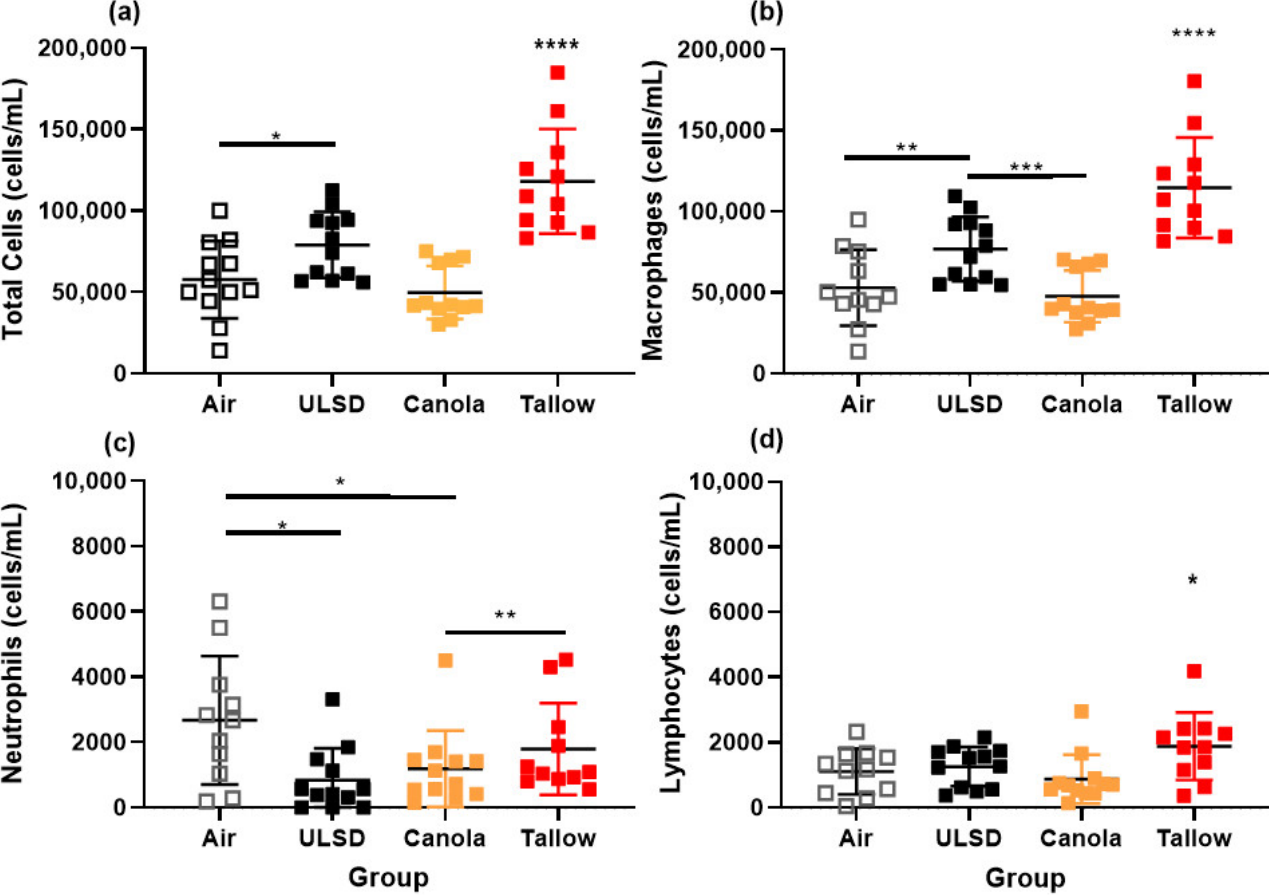
Figure 6. Cellular inflammation in bronchoalveolar lavage. Results are shown for ( a ) total cells, ( b ) macrophages, ( c ) neutrophils, and ( d ) lymphocytes ( n = 12, except Tallow where n = 11) (* = p < 0.05, ** = p < 0.01, *** = p < 0.001, **** = p < 0.0001, significant * values not located next to a line indicate that the group is significantly different to all other exposures). Note different scales. Data were analyzed using general linear modeling methodologies. Table 3. Mean (standard deviation) mediator levels in bronchoalveolar lavage fluid for mice ex- posed to Air, ULSD, Canola, or Tallow biodiesel exhaust for 2hr/day for 8 days ( n = 12). Data were analyzed using general linear modeling methodologies.